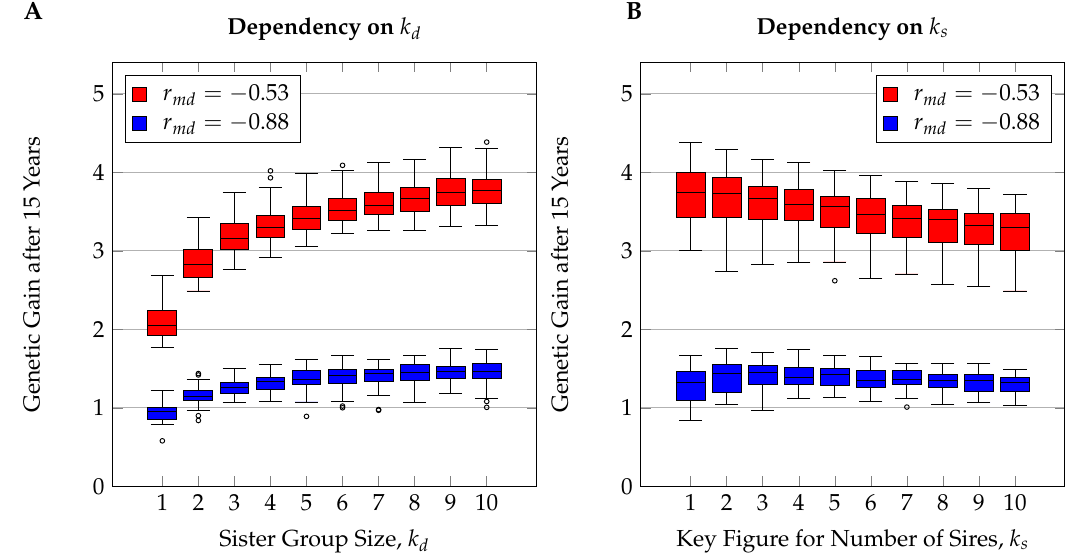
Key Figure for Number of Sires, k s Figure 5. Box plots showing the average genetic gain after 15 years for different sister group sizes ( A ) and different numbers of sires ( B ). In part ( B ), values for sister group size k d = 1 are omitted to avoid an excess of